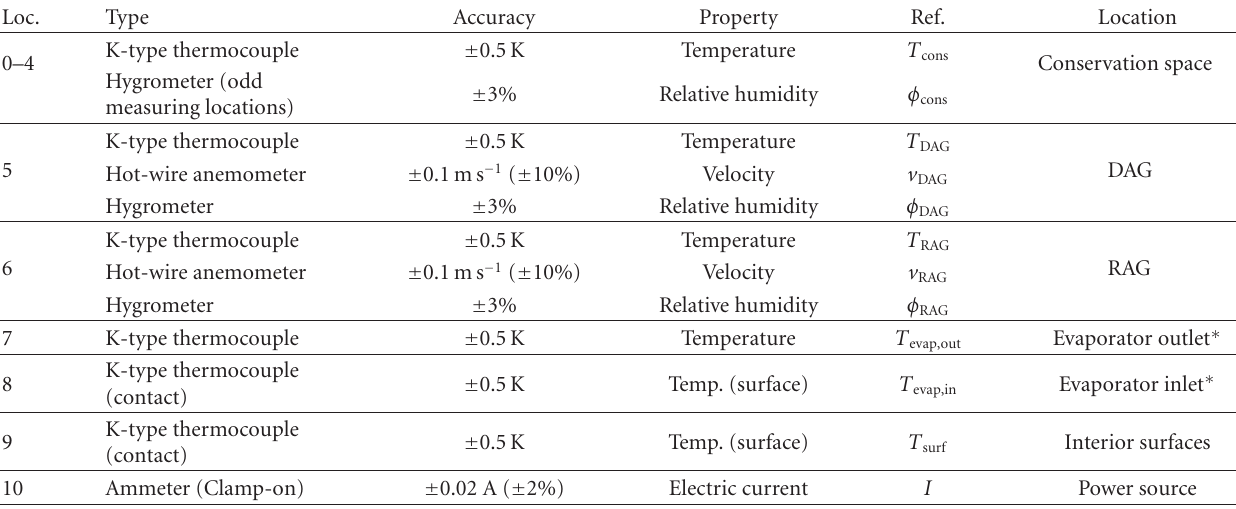
Table 1: Description of test probes and its location (see Figure